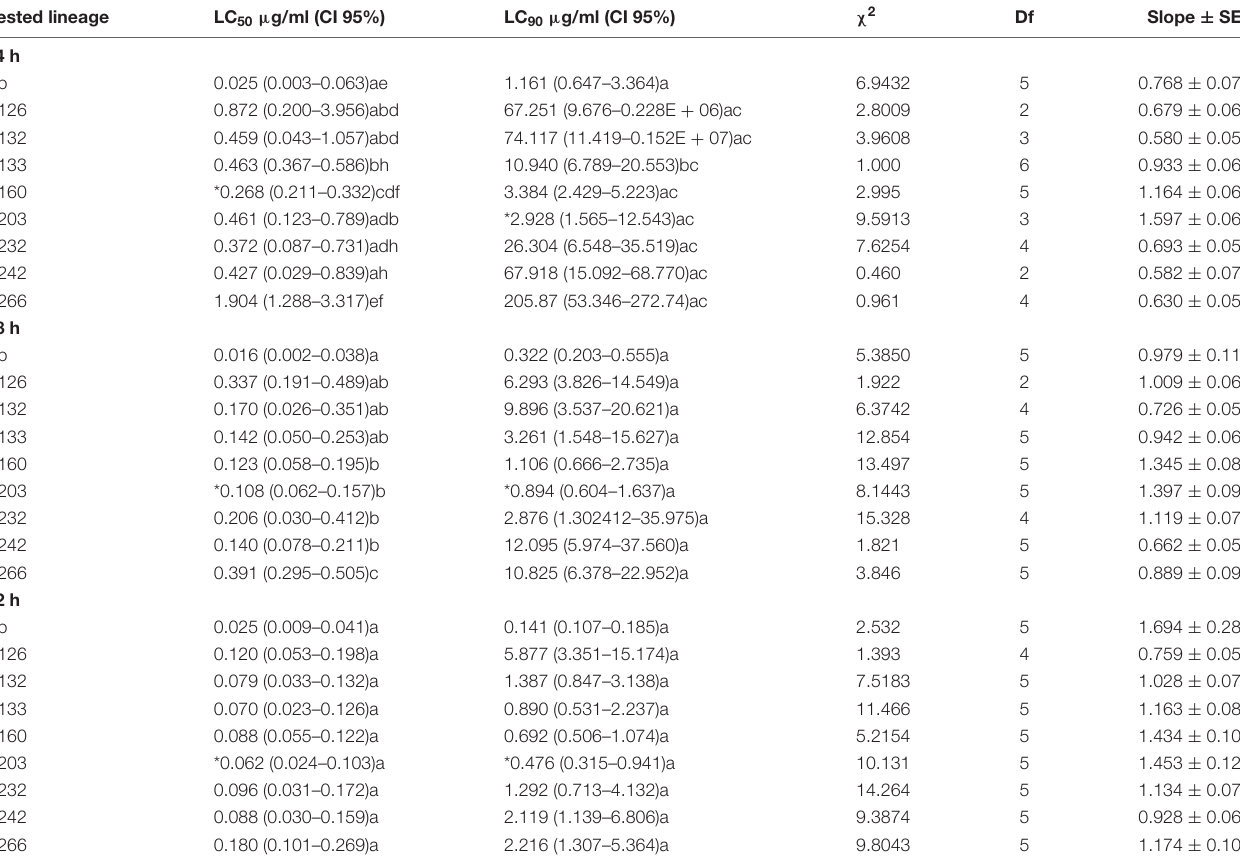
TABLE 2 | Lethal larvicidal concentration of liquid culture medium extracts obtained from fungal strains against 3rd instar Aedes aegypti larvae. Tested